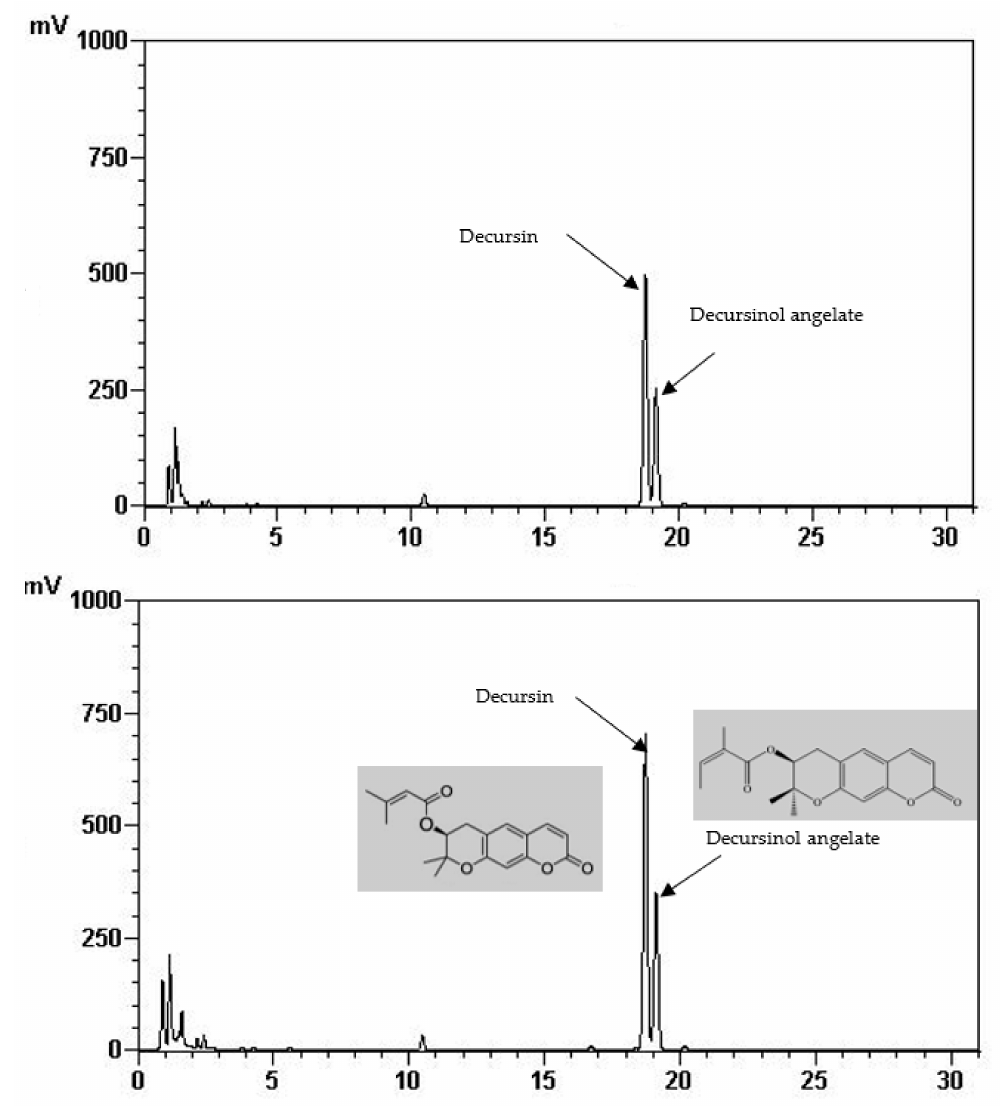
Figure 1. HPLC chromatogram of decursin and decursinol angelate of control (above) and treated AGN at 220 ◦ C